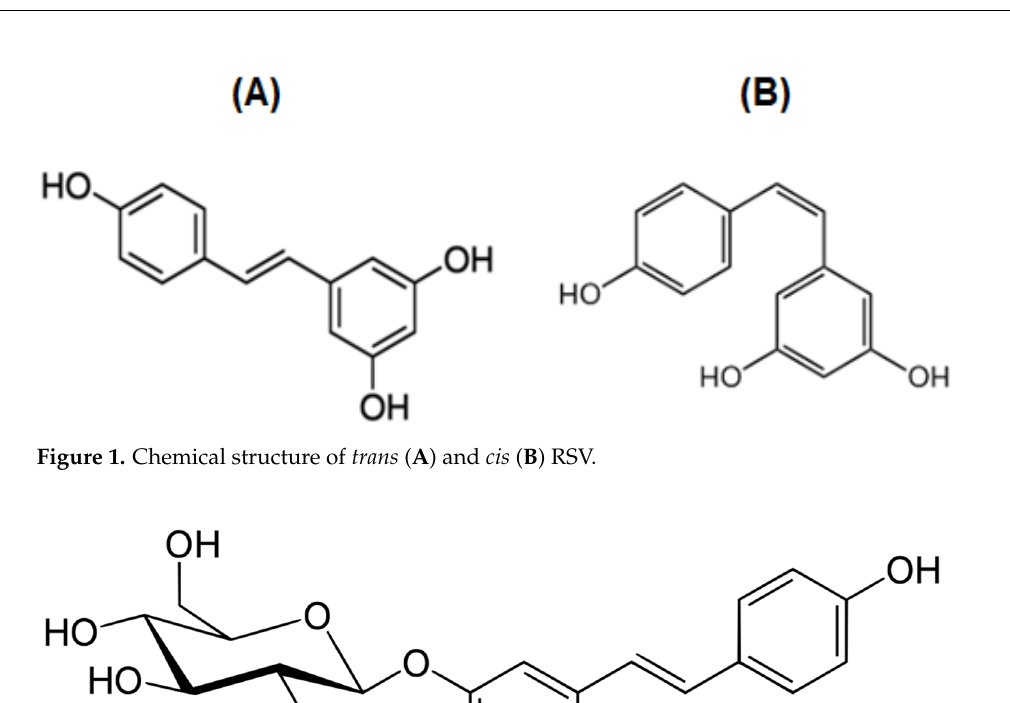
Figure 2. Chemical structure of PD.